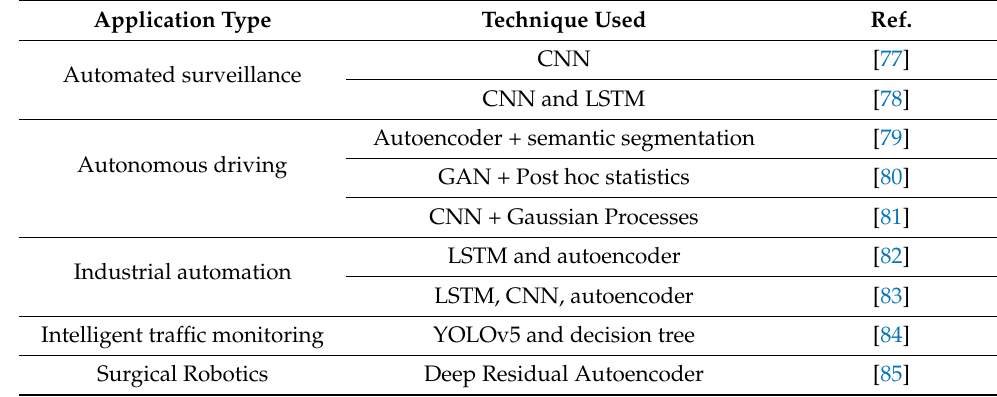
Table 4. Examples of applications of DL-based